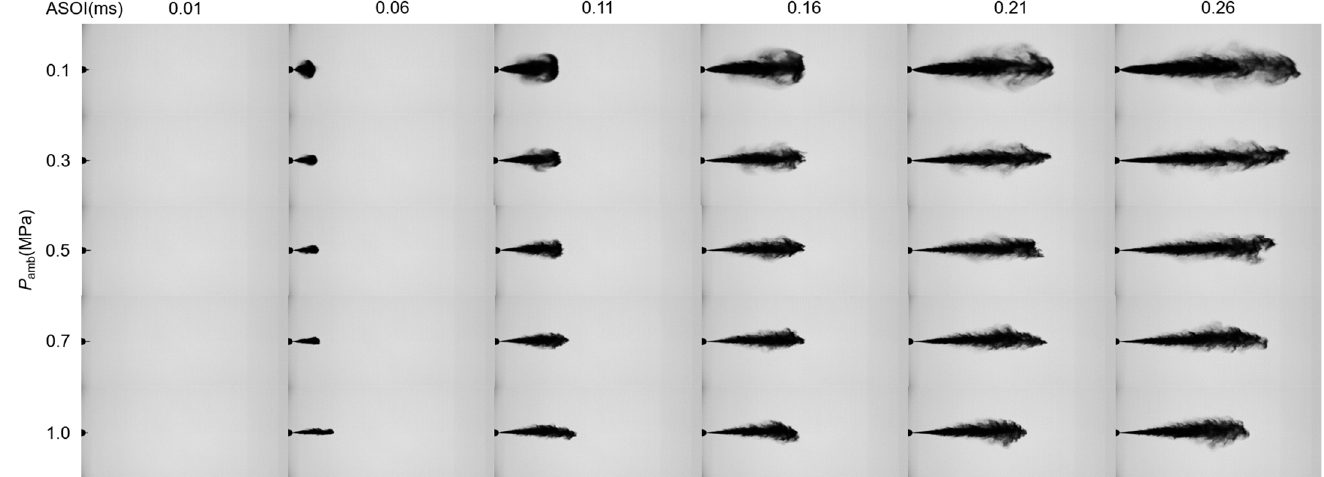
Figure 8. Spray images in flash boiling conditions, P inj = 100 MPa; fuel: liquid ammonia.